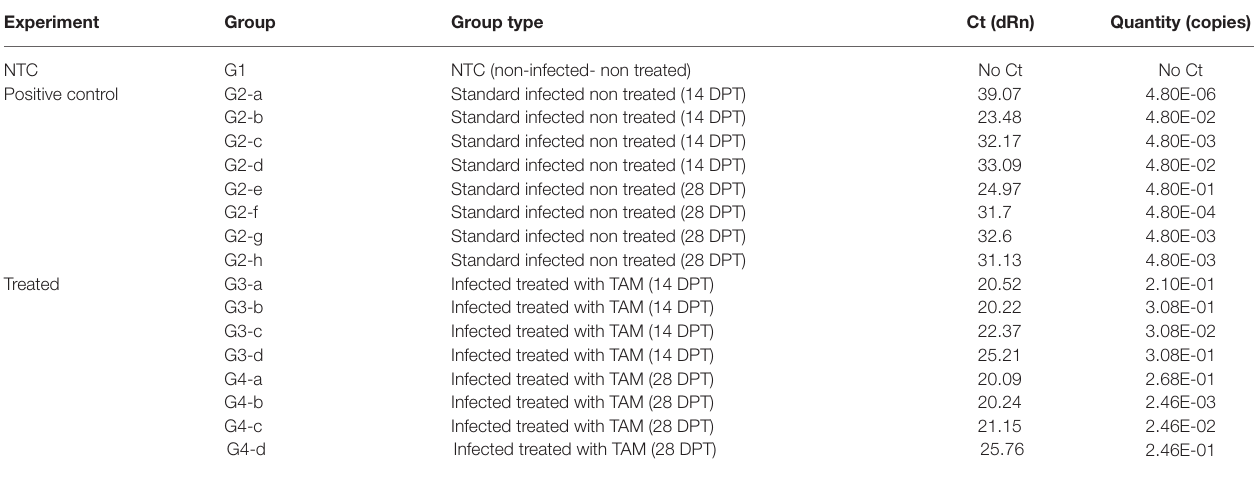
TABLE 4 | The CT values and absolute quantity of both the standard and the treated samples.